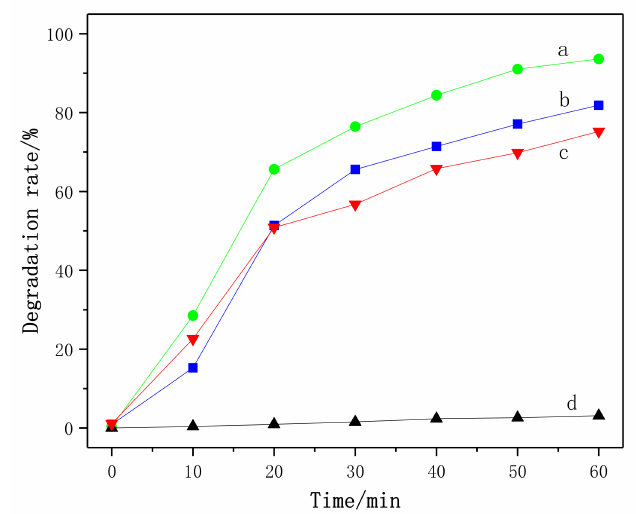
Figure 7. Curves of decolorization rate of methyl orange by di ff erent TiO 2 : ( a ) Ag-TiO 2 , ( b ) TiO 2 , ( c ) nano-TiO 2 , and ( d ) blank (without